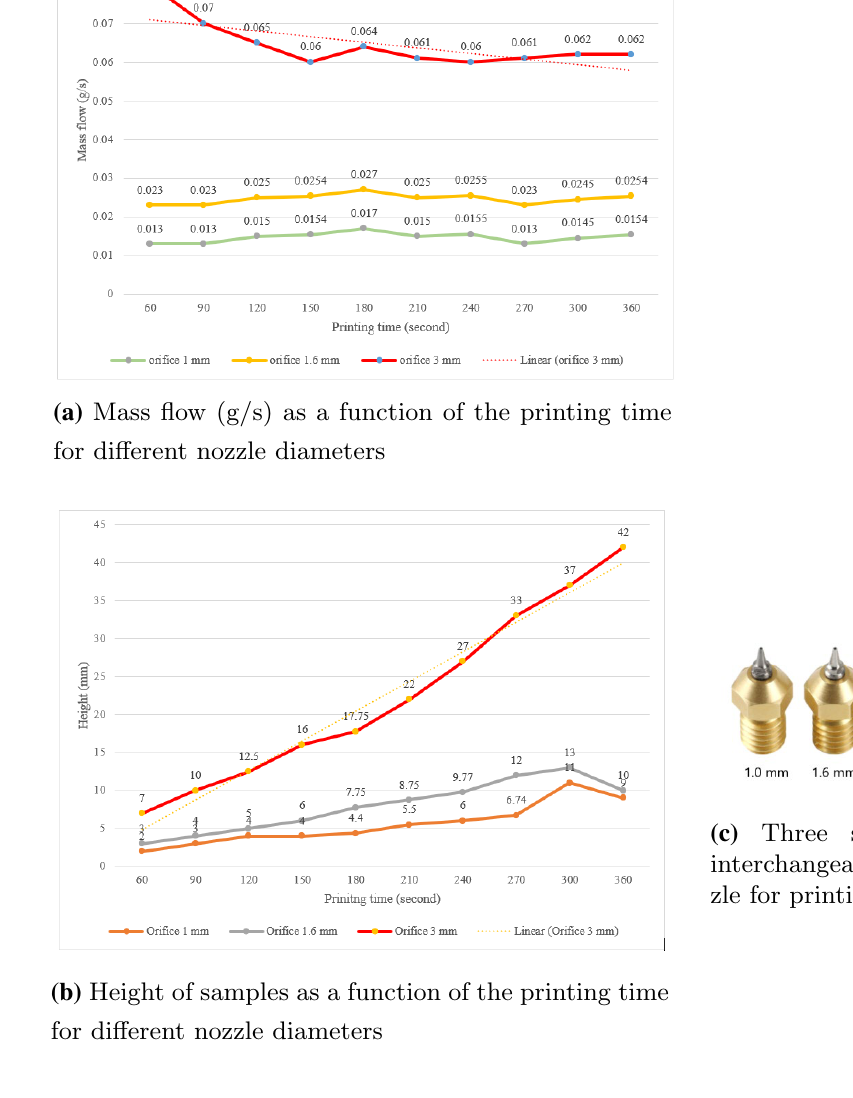
Fig. 7 All for the sample for- mulation W/C of 0.60